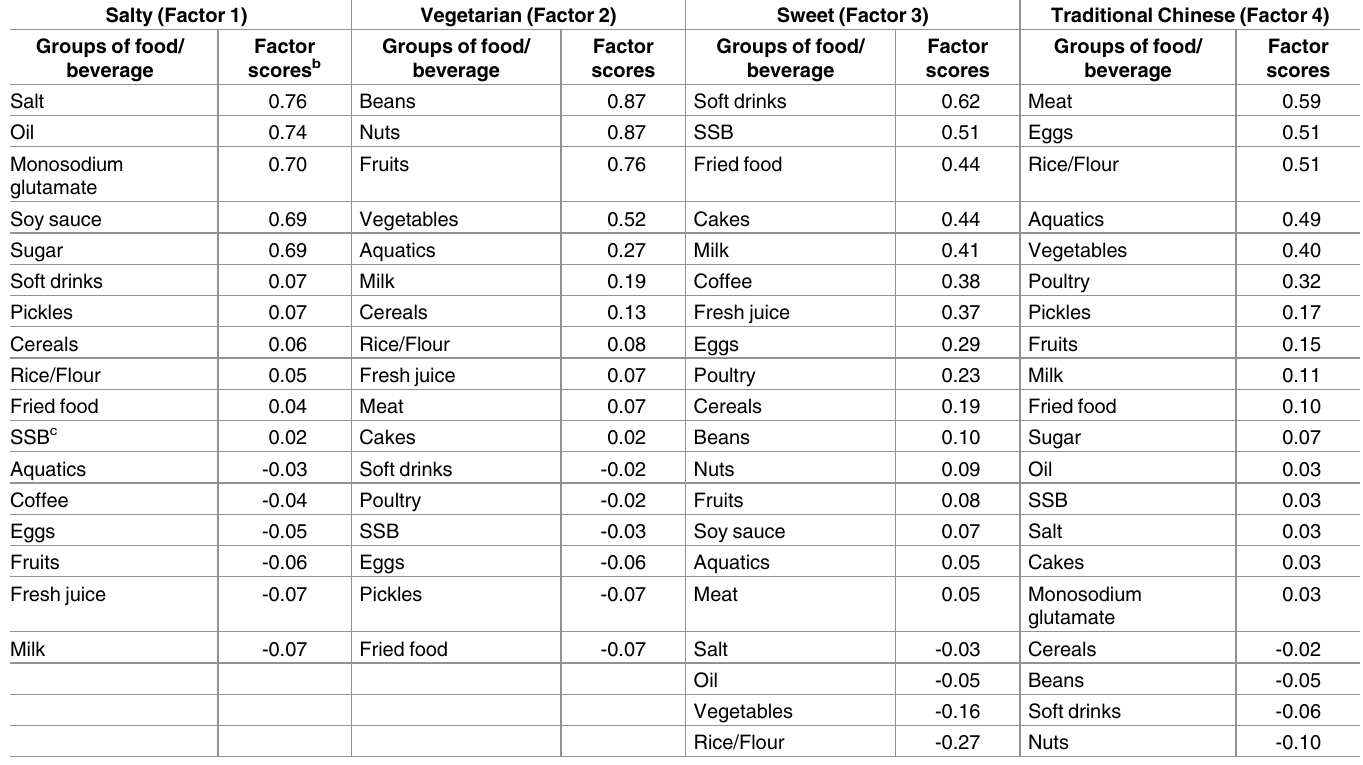
Table 2. Dietary patterns, groups of food/ beverageand factor scores a (N =